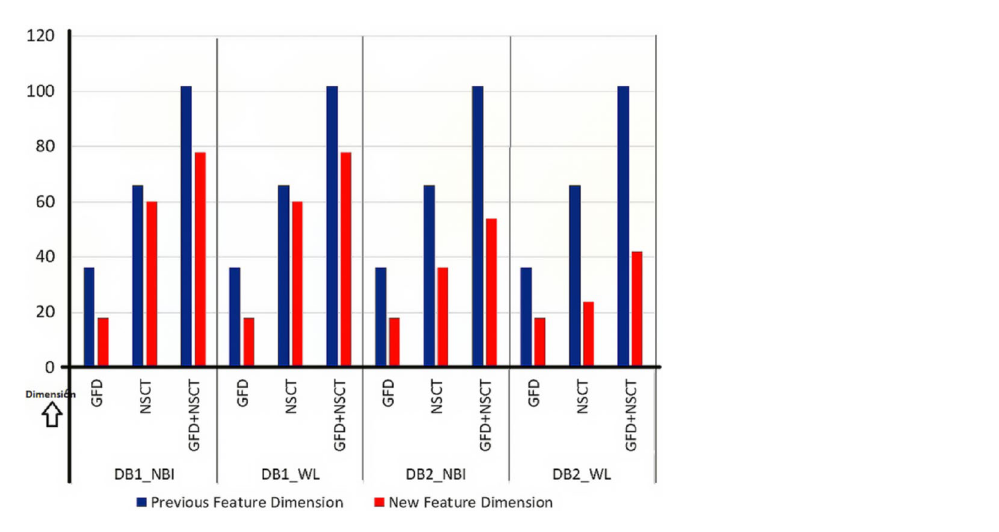
Figure 8. Change in feature